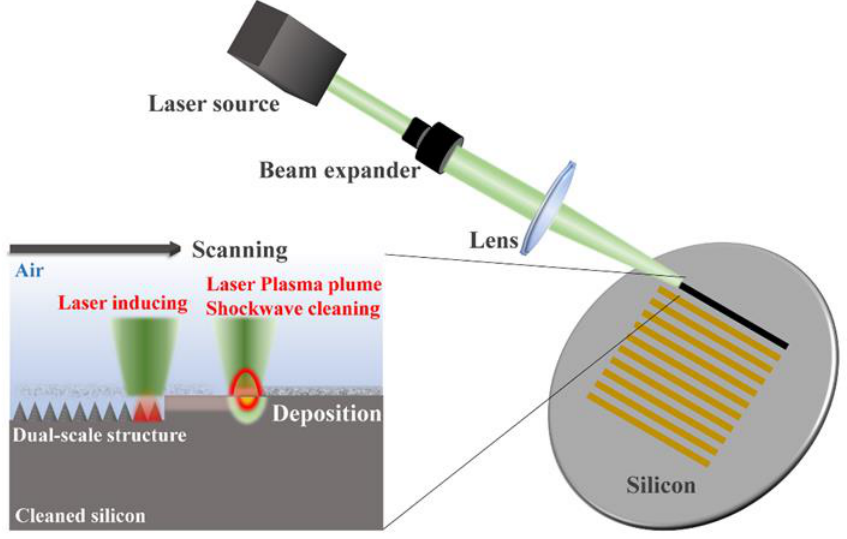
Figure 2. The schematic of experimental set up. The inset is a schematic diagram for the fabrication of black silicon.